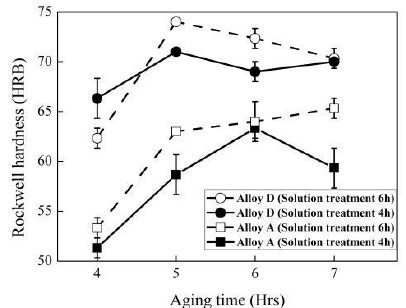
Figure 7. The hardness of alloys A and D as a function of solution treatment and aging times.